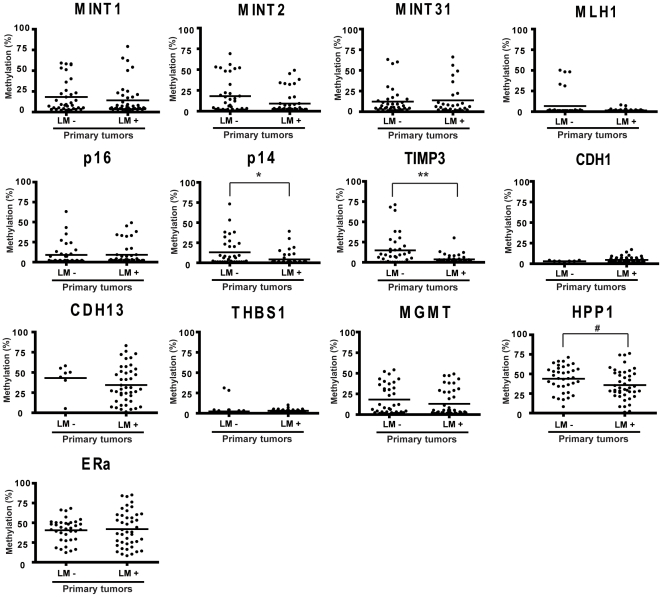
DNA methylation status of thirteen cancer-specific or age-related genes/CpG islands in primary CRCs without and with liver metastasis.Each dot represents the methylation level of an individual sample. Horizontal lines represent mean methylation levels for each group. *, P = .0005; **, P = .0113; #, P = .0452. LM-, primary CRCs without liver metastasis; LM+, primary CRCs with liver metastasis. CRCs, colorectal cancers.